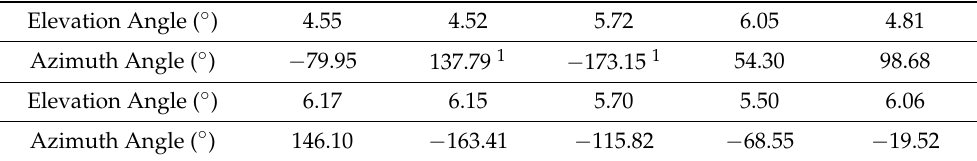
Table 19. DOA estimation by CPCMA-ESPRIT for inner race fault signal at 725 rpm.